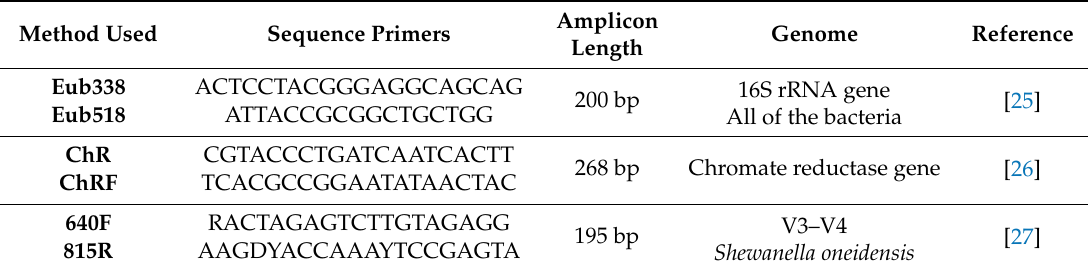
Table 2. Primers used for PCR amplifications in this